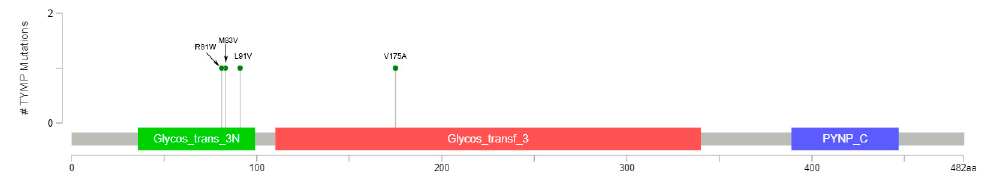
Figure 5. The aminoacidic sequence of TYMP gene; the protein domains are represented in green, the glycosyltransferase family helical bundle domain, in red the glycosyltransferase family a/b domain, and in blue the pyrimidine nucleoside phosphorylase C-terminal domain. Mutations are depicted as green lollipops with the annotation of the protein change above.